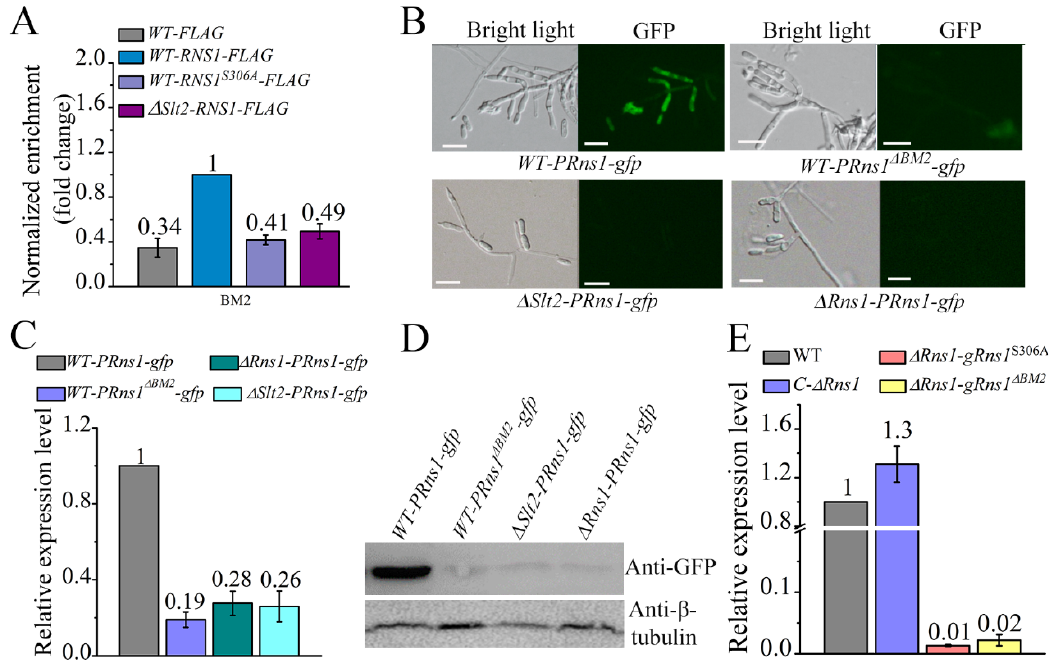
Figure 6. Phosphorylation of the Sec-306 of RNS1 by Slt2 facilitates the binding of RNS1 to its own promoter to self-induce expression during conidiation. ( A ) ChIP-qPCR analysis of the binding to the BM2 motif in the Rns1 promoter of the proteins RNS1::FLAG or RNS1 S306A ::FLAG. WT-FLAG: a strain expressing the tag FLAG in the WT strain; WT-RNS1- FLAG: a strain expressing the fusion protein RNS1::FLAG protein in the WT . WT-RNS1 S306A -FLAG : a strain expressing RNS1 S306A ::FLAG protein in WT. ∆ Slt2-RNS1-FLAG : a strain expressing RNS1::FLAG protein in ∆ Slt2. Microscopic observation ( B ), qRT-PCR analysis ( C ) and Western blot analysis ( D ) of GFP expression during conidiation. WT-PRns1-gfp : a strain with gfp driven by the native Rns1 promoter ( PRns1 ) in WT; WT-PRns1 BM2 -gfp : gfp driven by PRns1 ∆ BM2 (the BM2 motif was mutated in Rns1 ’s promoter PRns1 ) in WT; ∆ Rns1-PRns1-gfp: gfp driven by the promoter PRns1 in ∆ Rns1 ; ∆ Slt2-PRns1-gfp : gfp driven by the promoter PRns1 in ∆ Slt2 . Bars, 10 µ m. ( E ) qRT-PCR analysis of the expression of Rns1. ∆ Rns1- gRns1 S306A : a strain constructed by complementation of the mutant ∆ Rns1 with a mutated genomic clone of Rns1 ( gRns1 ) with the serine residue at position 306 changed to alanine; ∆ Rns1-gRns1 ∆ BM2 : a strain constructed by complementation of the mutant ∆ Rns1 with a gRns1 mutant with the BM2 motif